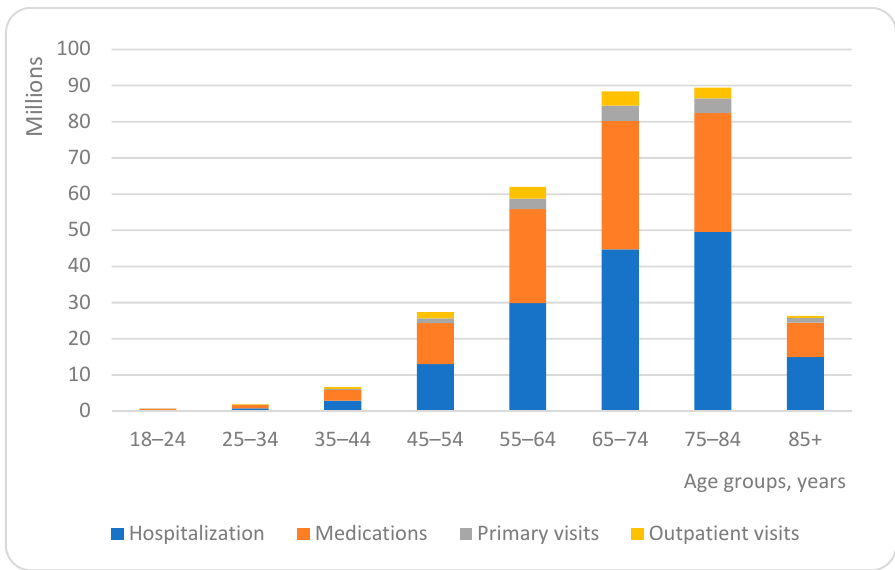
Figure 2. Share of health care costs in different age groups.